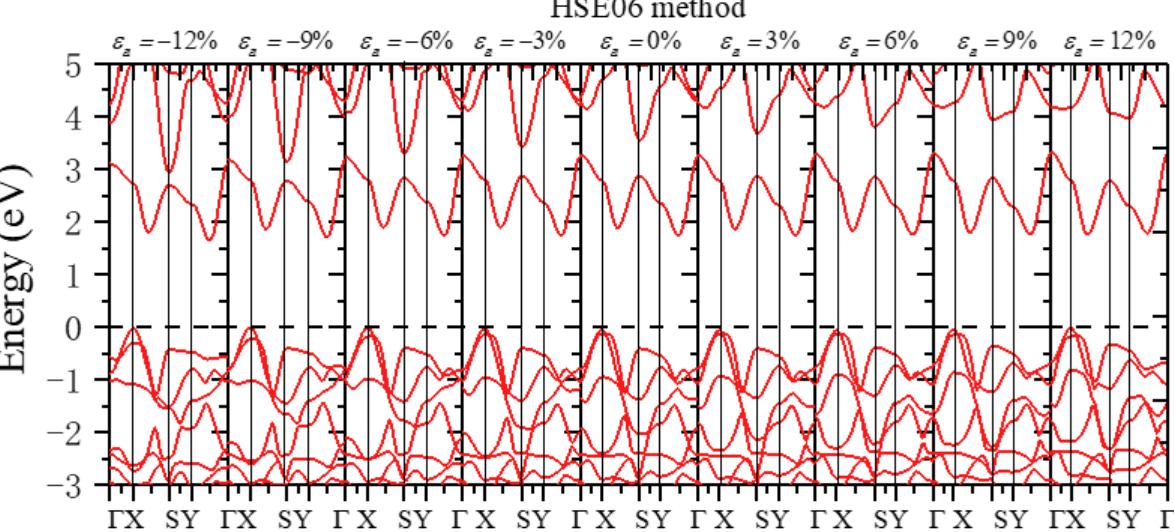
Figure 8. The band structure when different uniaxial strains along the a -direction were applied using the HSE06 method.